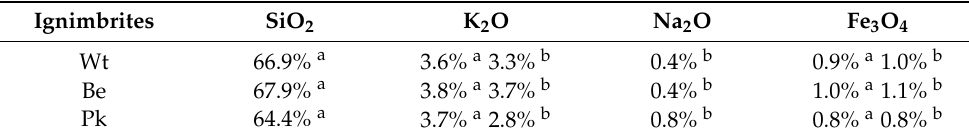
Table 2. Results from chemical analysis for the main elements.